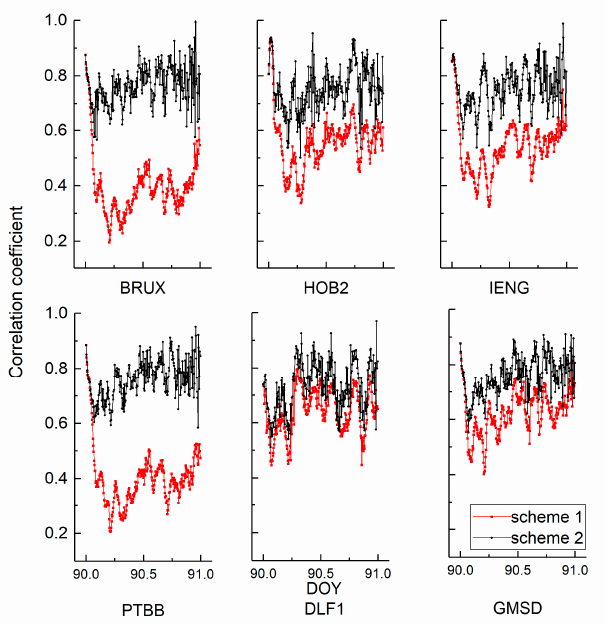
Figure 3. The correlation coefficients between the kinematic receiver clock offsets and height posi- tion estimates.